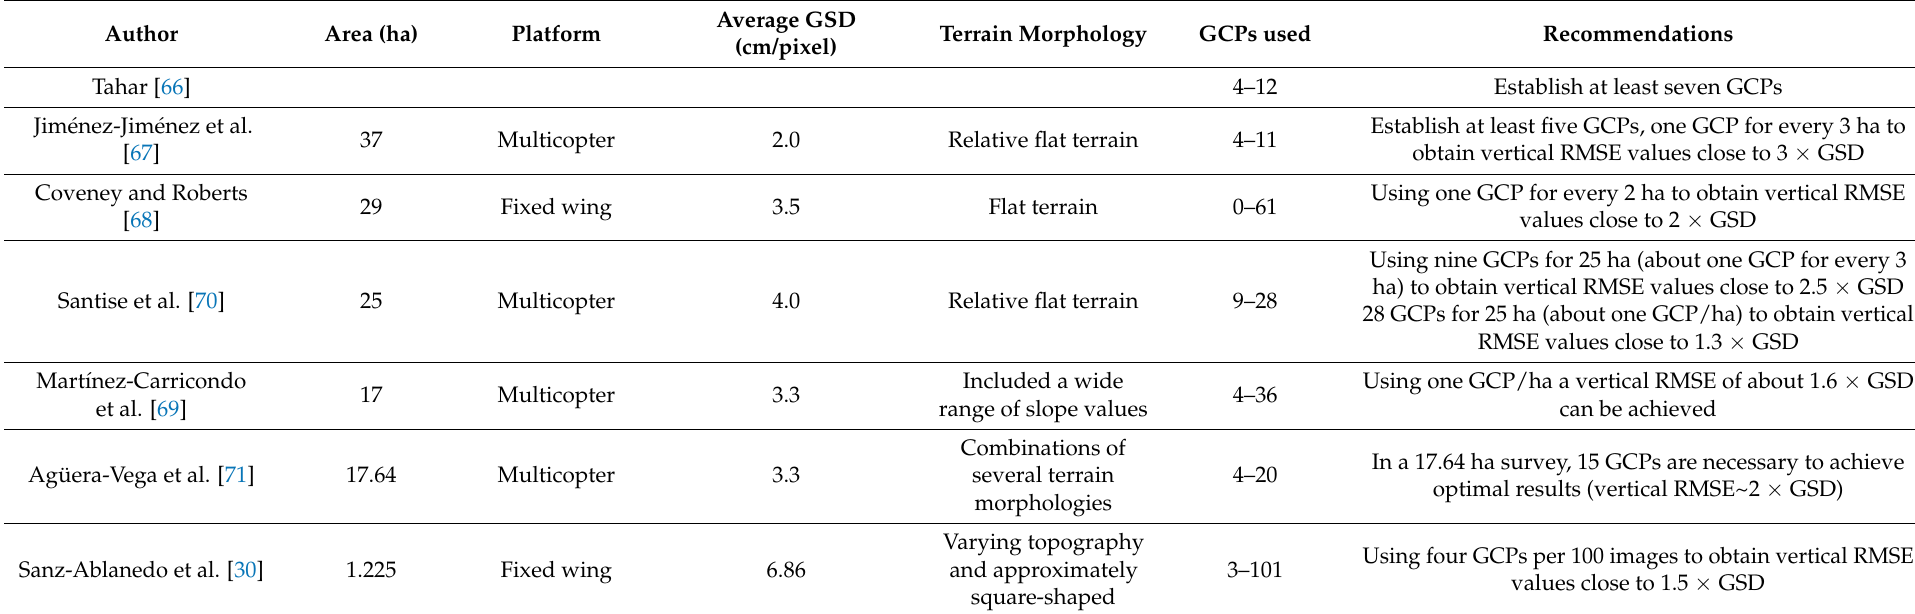
Table 4. Recommendations regarding the number of GCPs reported in different